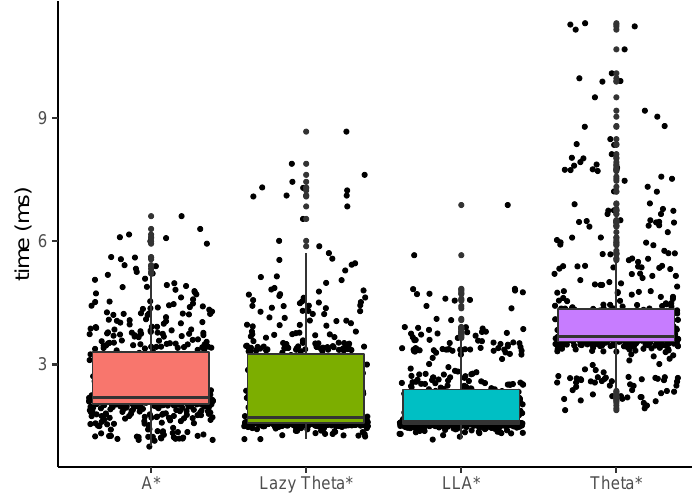
Figure 12. The execution time of 500 times of the maze test #2 using the four planners. LLA* is the fastest among these planners on